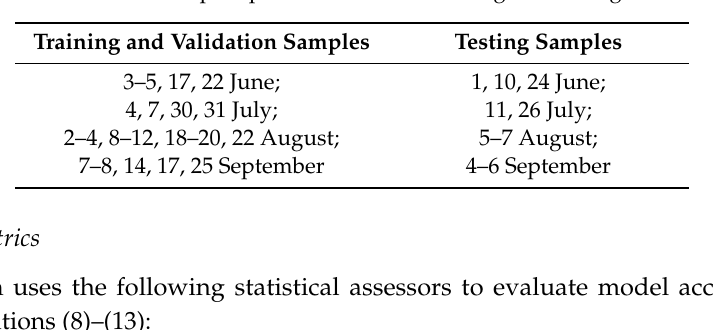
Table 3. Dates of precipitation events in training and testing data. Training and validation samples